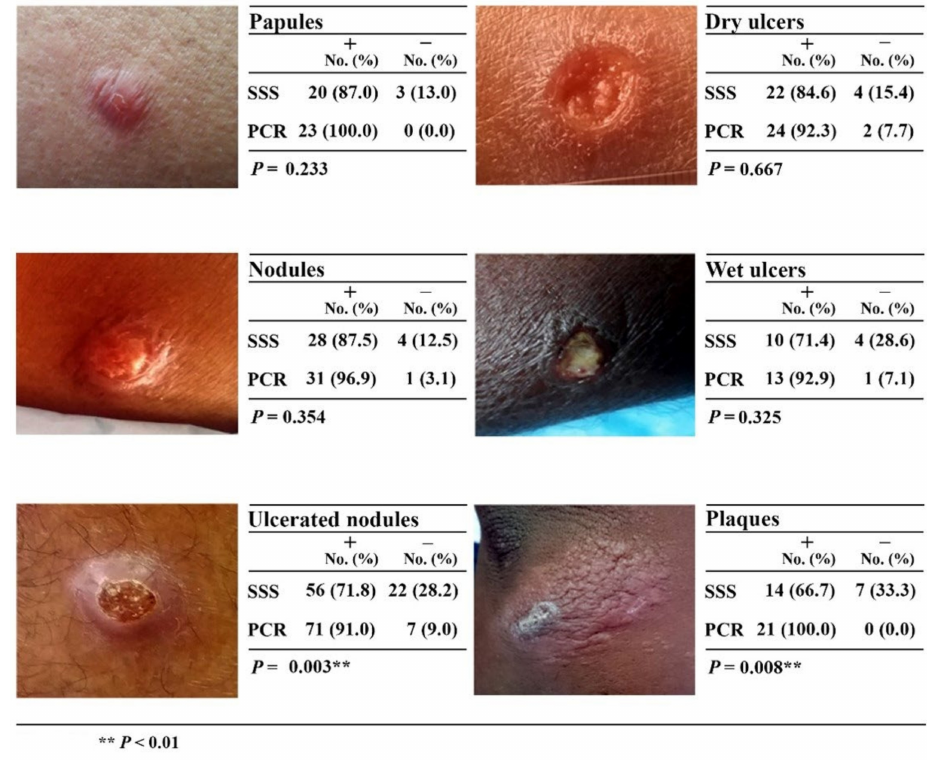
Figure 5. Diagnostic ability of SSS and nested PCR against the nature of the skin lesions: ** p <